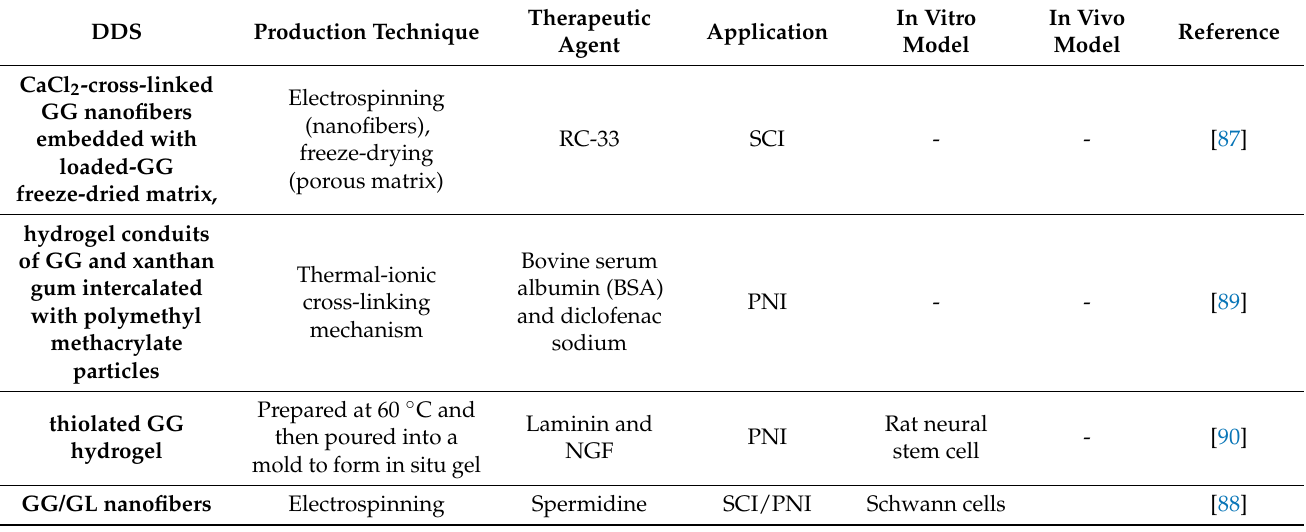
Table 6. Summary of GG-based DDSs for SCI. DDS description, production technique, therapeutic agent delivered, and in vitro and in vivo models exploited for efficacy assessment are